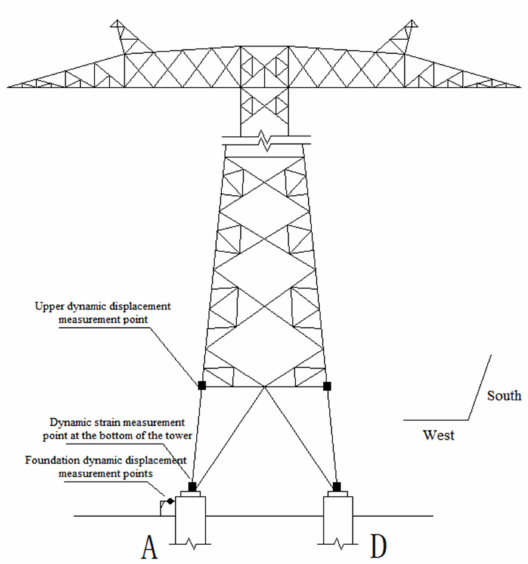
Figure 2. Transmission-line tower dynamic measurement point